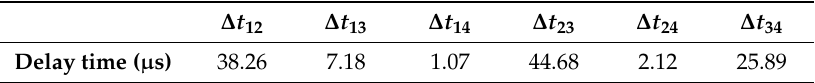
Table 2. Delay time during multistage detection.